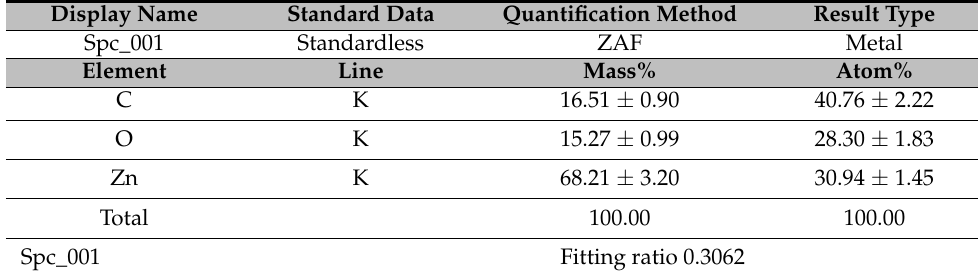
Table 3. EDS result of ZnONPs of leaf extracts of R. sativus showing fitting